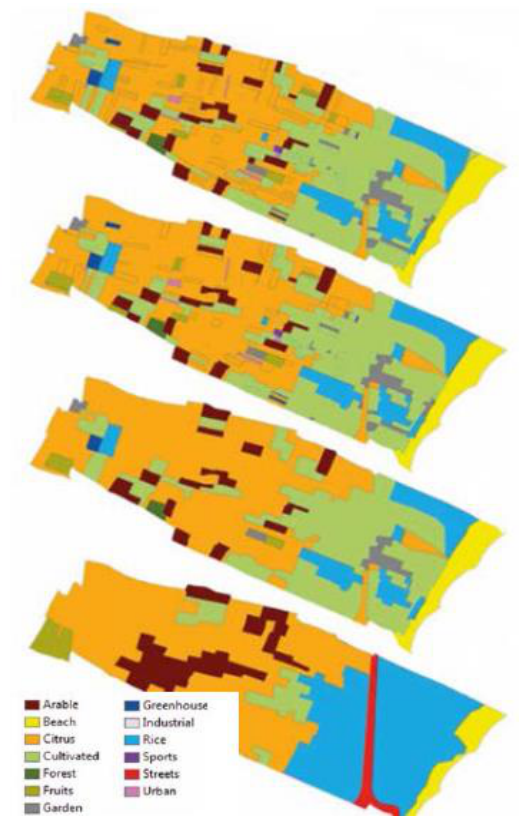
Figure 5. A series of automated generalization technique on land use by Dimov at el. (2014)